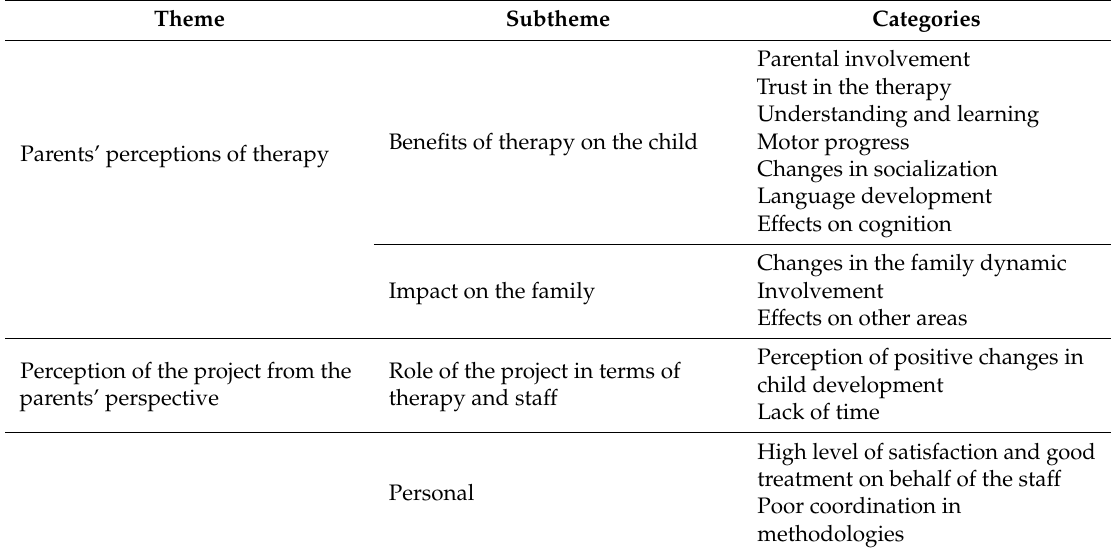
Table 1. Summary of study themes, subthemes, and categories.